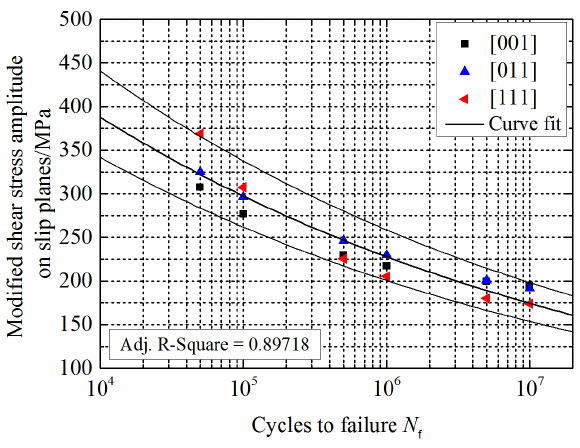
Figure 3. Fatigue life prediction for DD6 material at 700 °C using the proposed model.